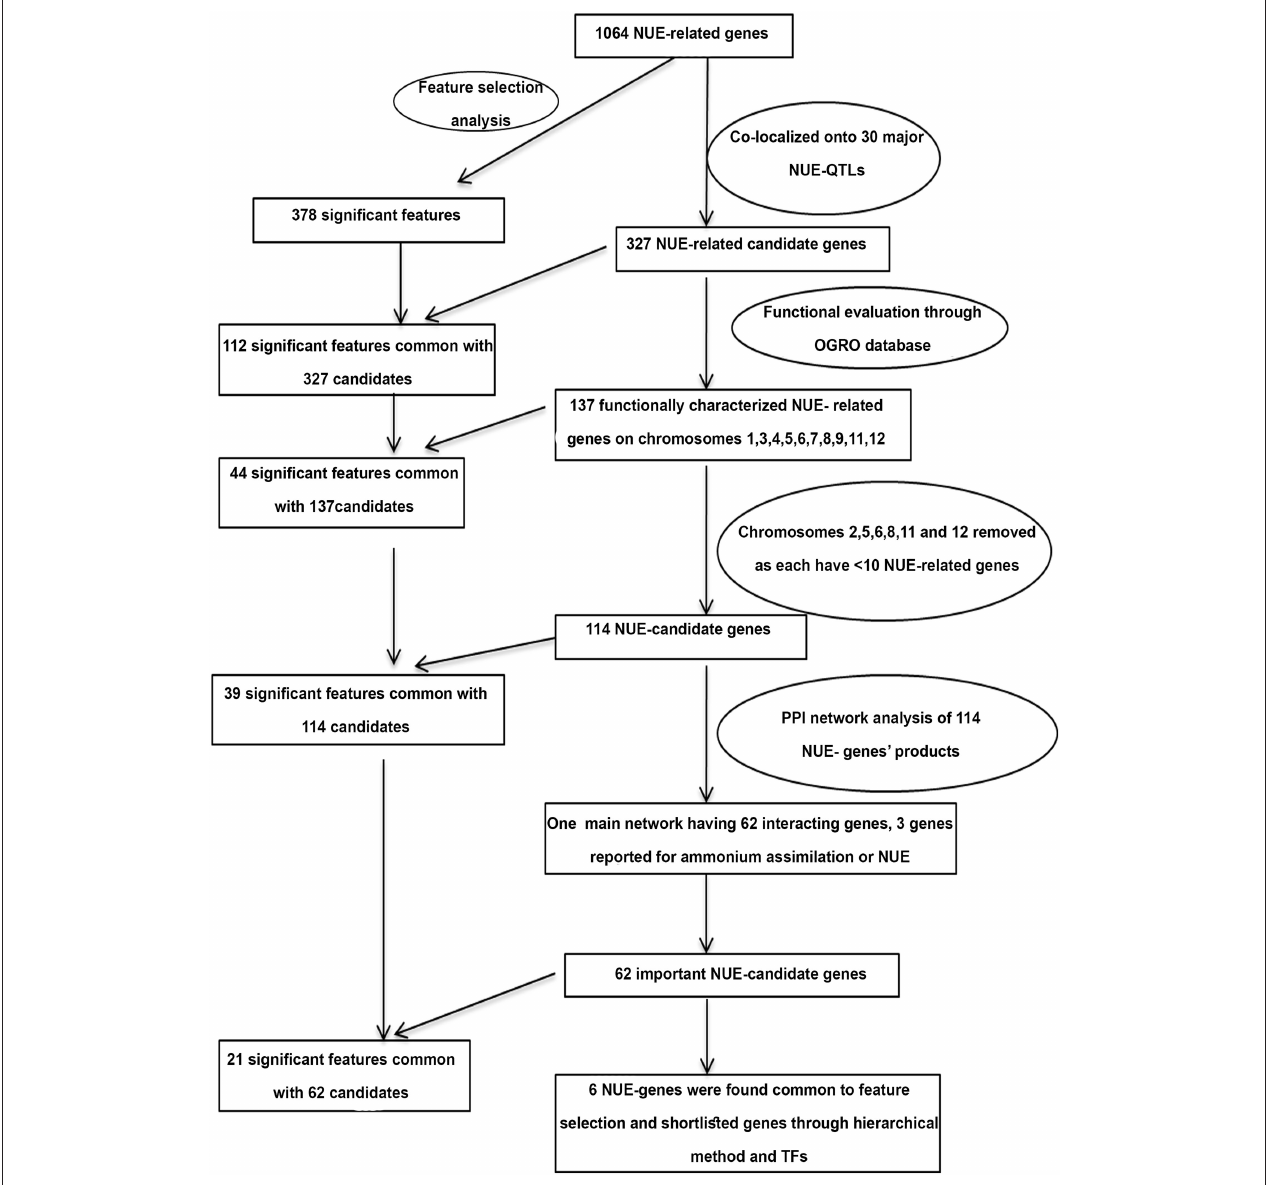
FIGURE 6 | Hierarchically shorted candidate genes and independent Feature Selection method to identify NUE-candidate genes.